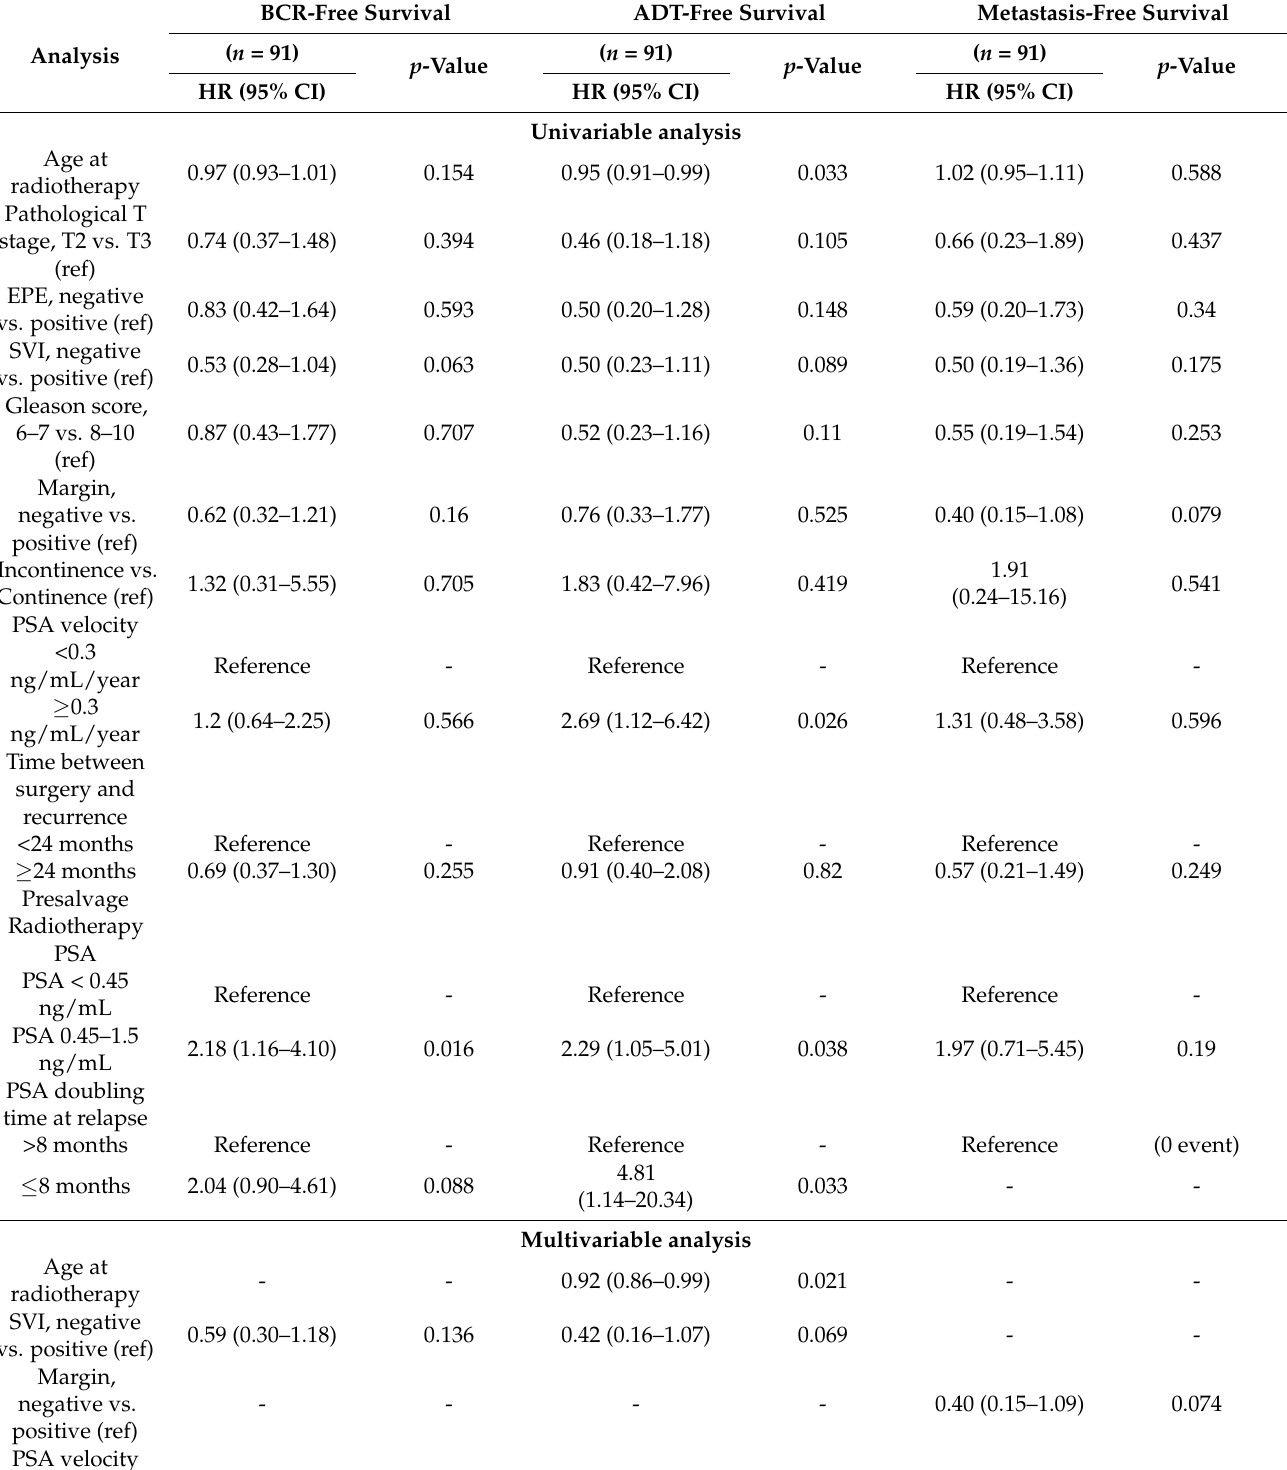
Table 2. Univariable and multivariable analysis for biochemical recurrence (BCR)-free survival, androgen-deprivation ther- apy (ADT)-free survival, and metastasis-free survival for patients with a pre-salvage radiotherapy PSA below 1.5